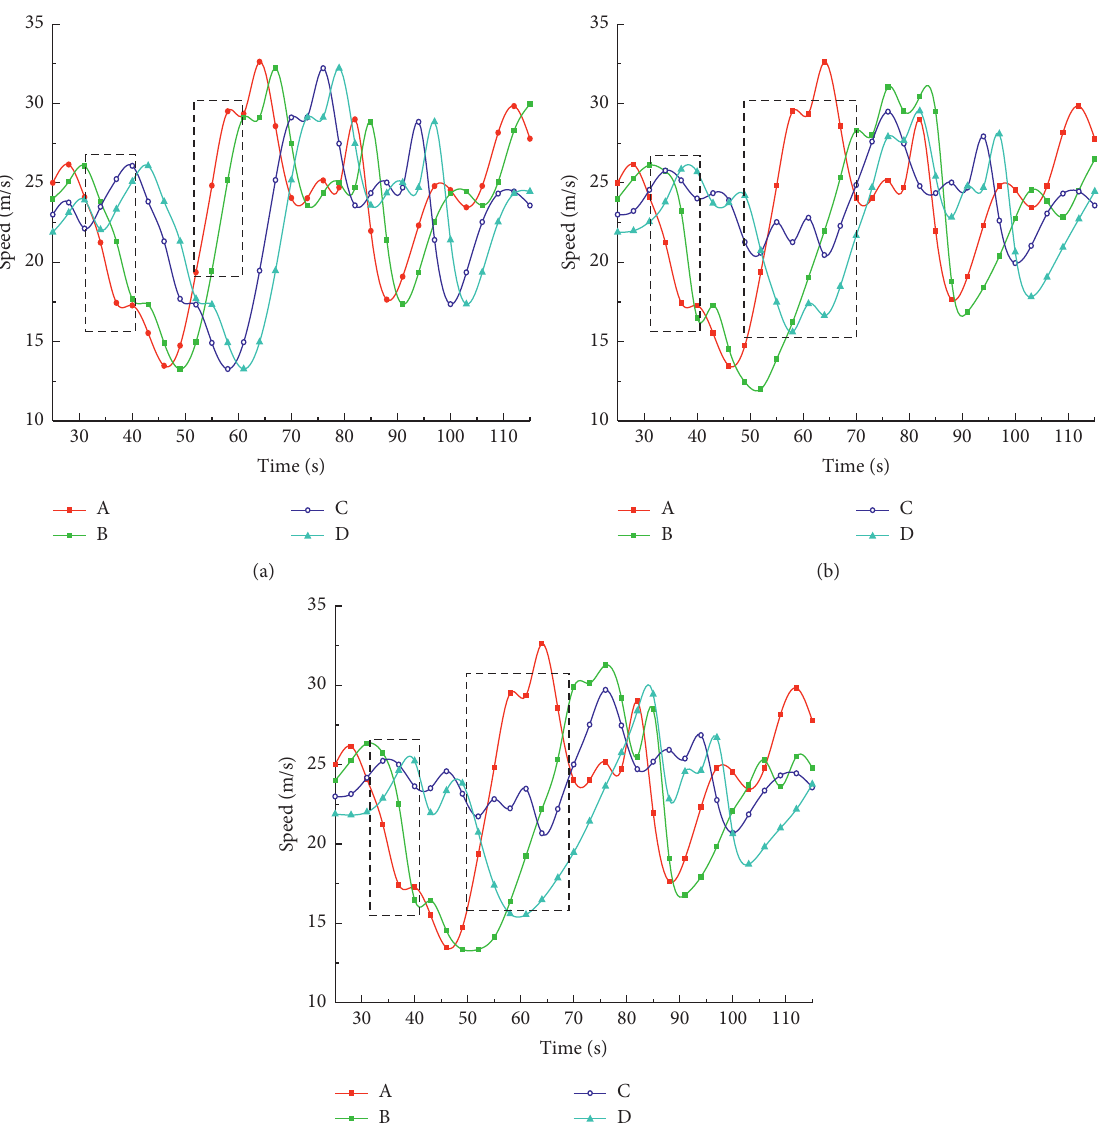
Figure 11: Measured speed curve and speed curves under different vehicle-following models. (a) OV following model. (b) Molecular following model. (c) Measured